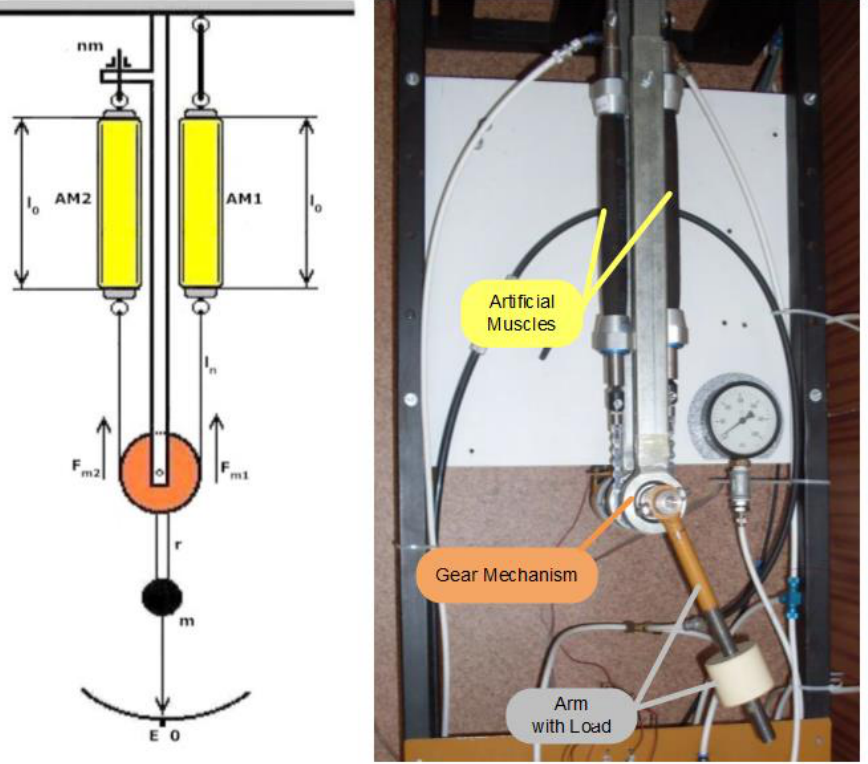
Figure 2. Experimental actuator based on PAM—An antagonistic connection of pneumatic artifi- cial muscle.